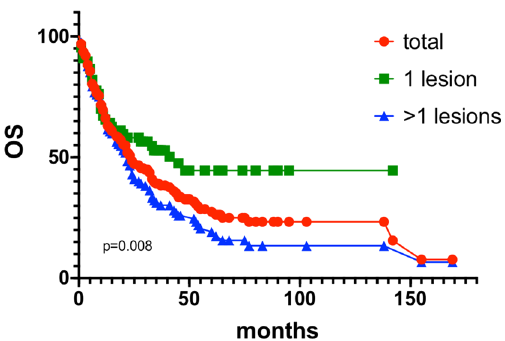
Fig. 5 OS and subgroup analysis (number of